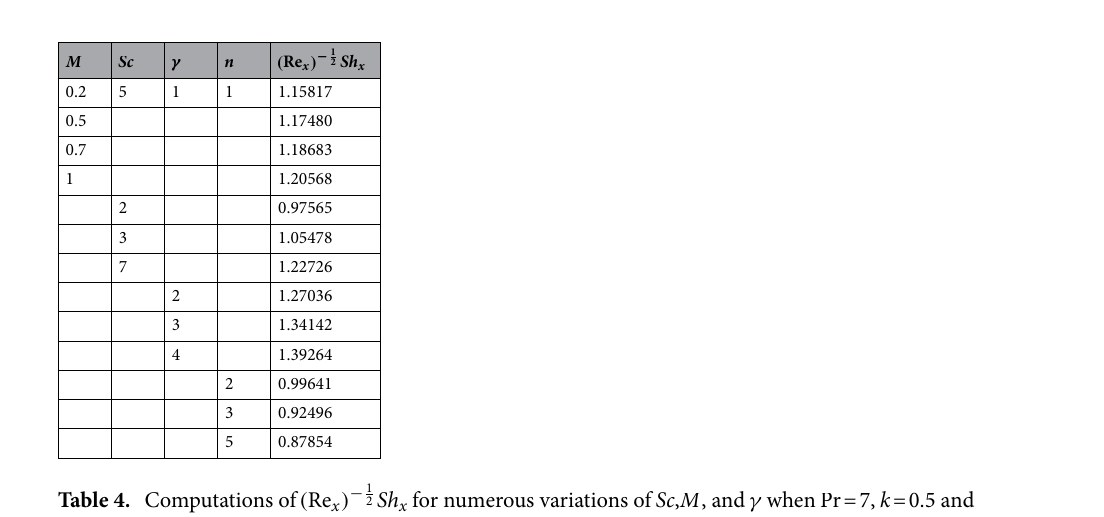
Table 4. Computations of ( Re x ) − B 1